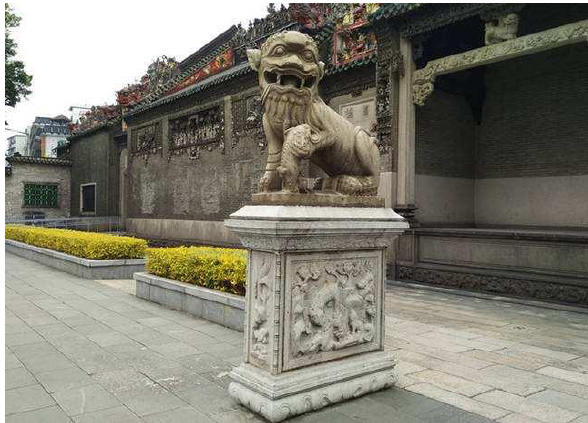
Figure 17. The male lion at Chen Clan Temple. Grey sculpture is a unique outdoor decorative art found in Guangdong buildings.